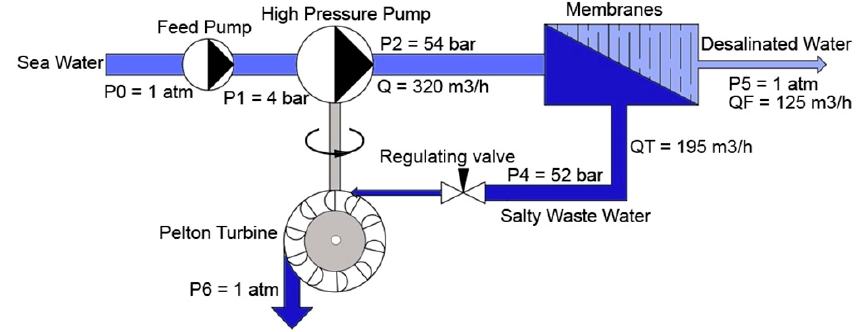
Figure 16. Schematic diagram of the cycle performance package [ Error! Reference source not found. ].